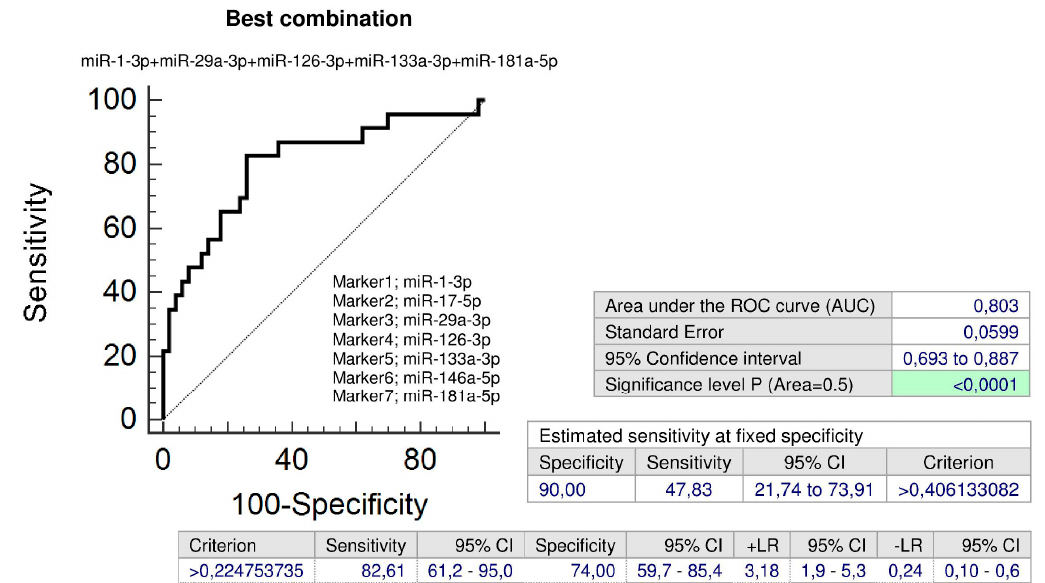
Figure 7. Combined postnatal screening of microRNAs in the identification of children with normal postnatal clinical findings descending from GH pregnancies. Postnatal combined screening of miR-1-3p, miR-29a-3p, miR-126-3p, miR-133a-3p and miR-181a-5p showed the highest accuracy for the identification of children with normal clinical findings with a prior exposure to GH at a higher risk of later development of cardiovascular/cerebrovascular diseases.